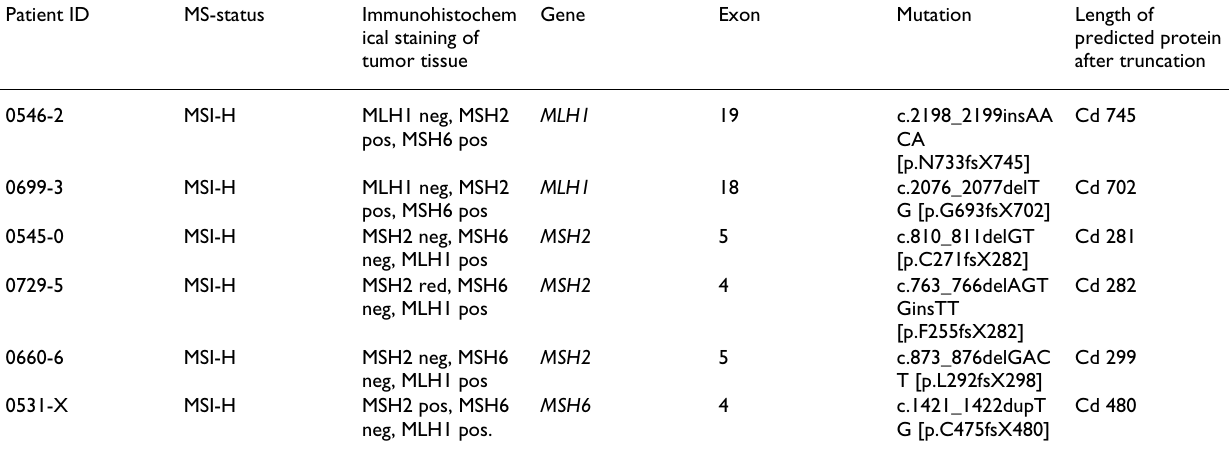
Table 2: Microsatellite status and immunohistochemical staining of tumor tissue, result of sequencing analysis in all investigated patients. Patient